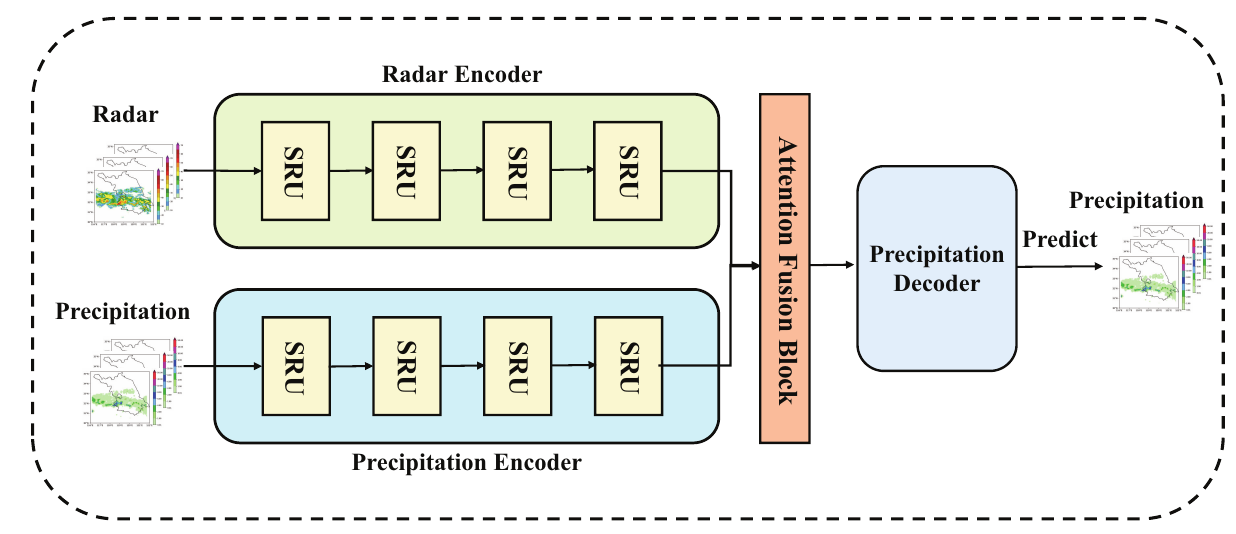
Figure 2. Architecture of AF-SRNet. It contains two encoders, a decoder, and a fusion block.